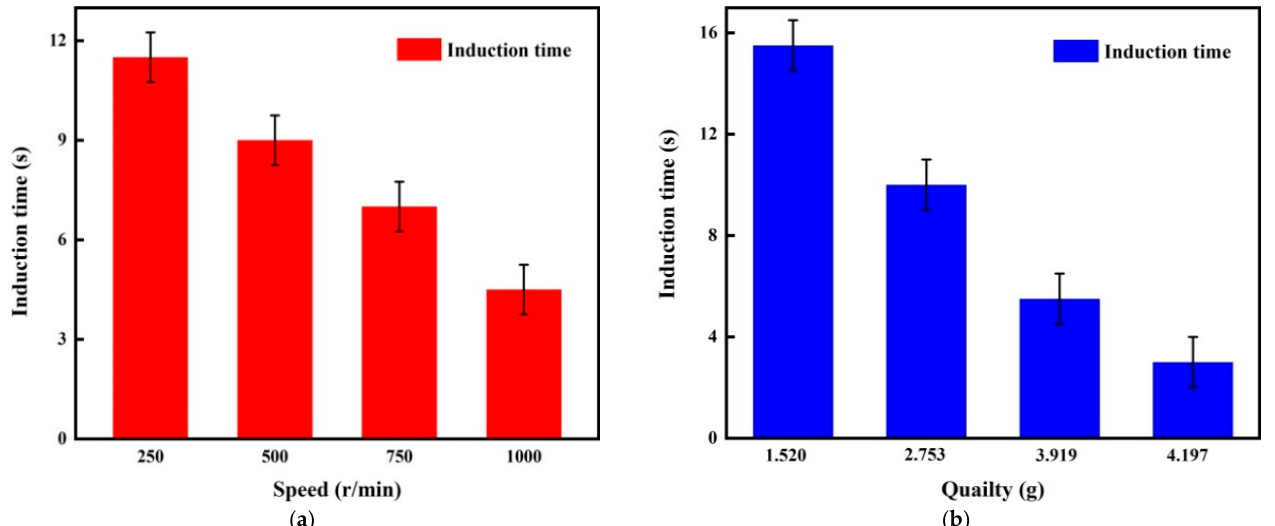
Figure 6. CPCM average induced crystallization time at 750 r/min ( a ) and when the mass is 2.753 g ( b ).